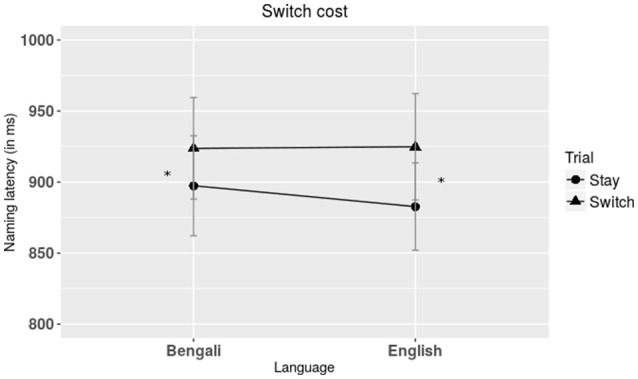
Plot showing response times for L1 and L2 naming during stay and switch trials. Symmetric switch costs were observed during switching between the two languages. Note: *p < 0.01.